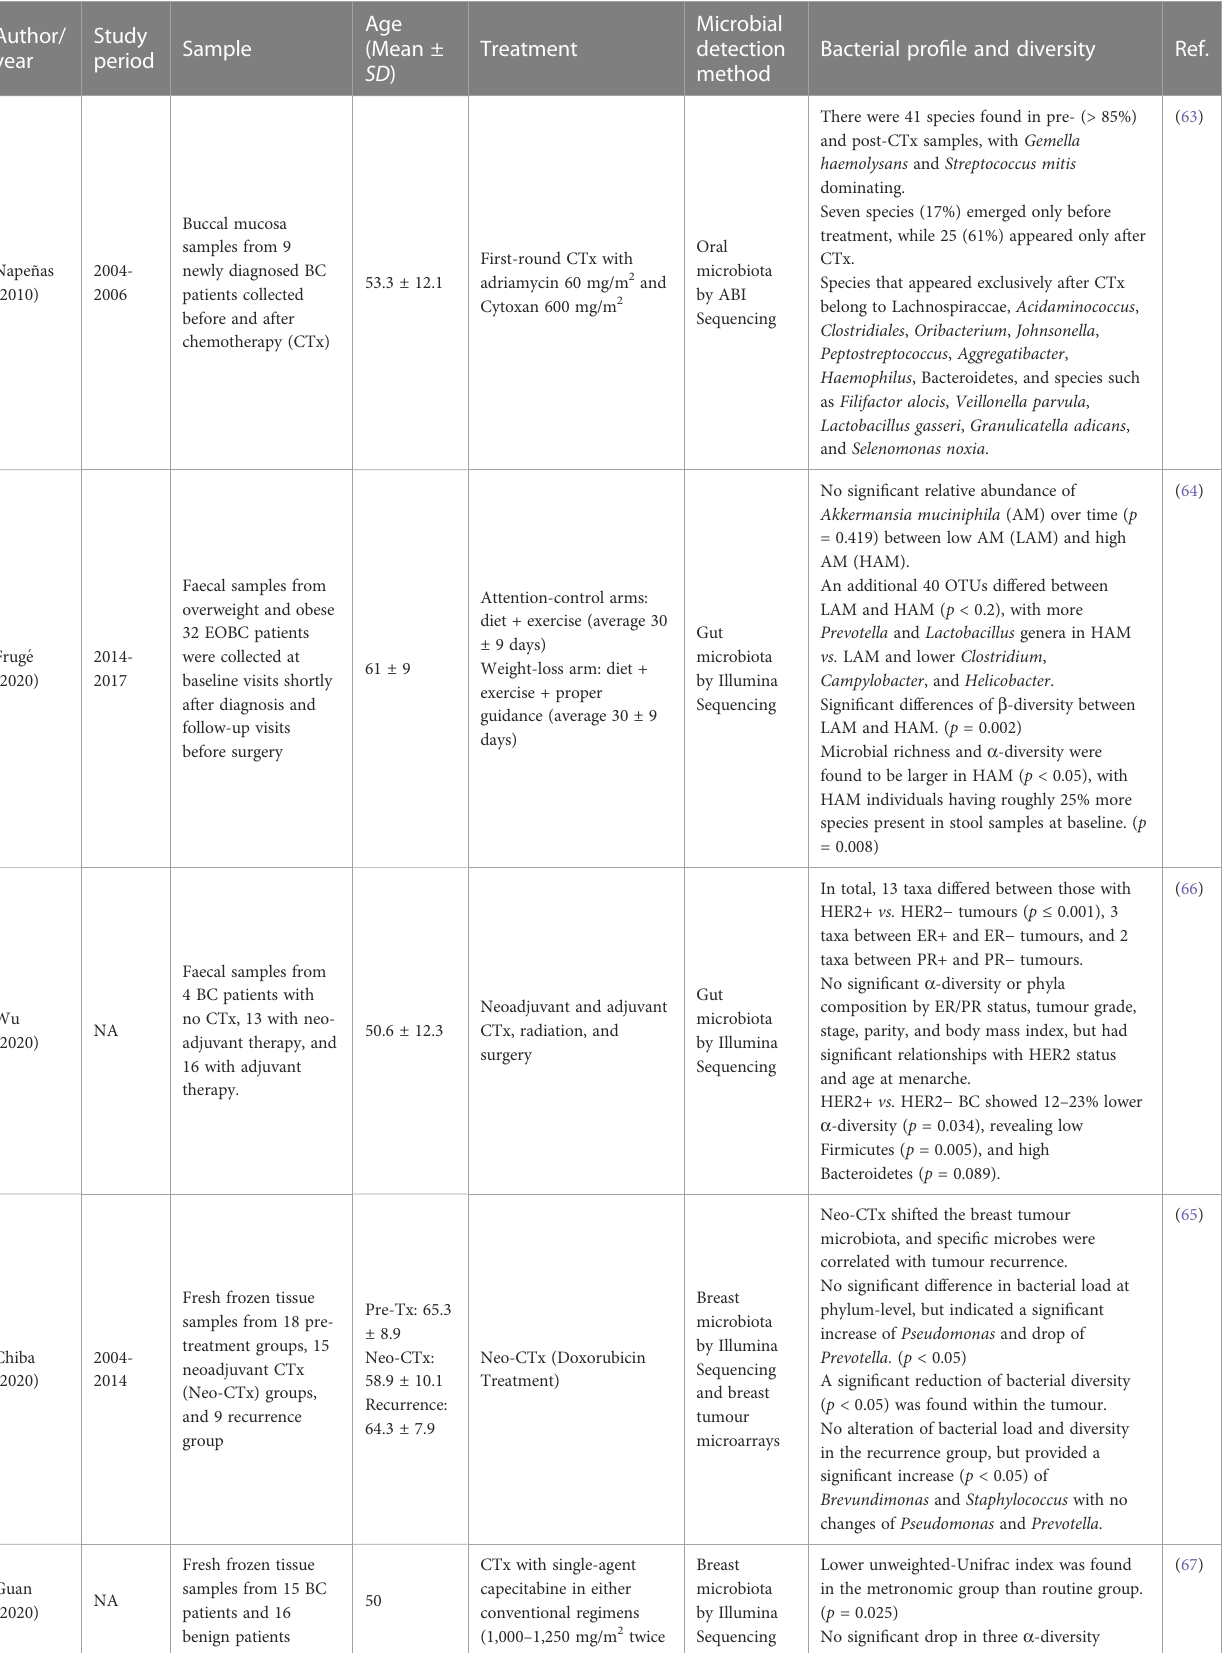
TABLE 4 Characteristics of non-randomized intervention trials and their microbial pro fi ling and